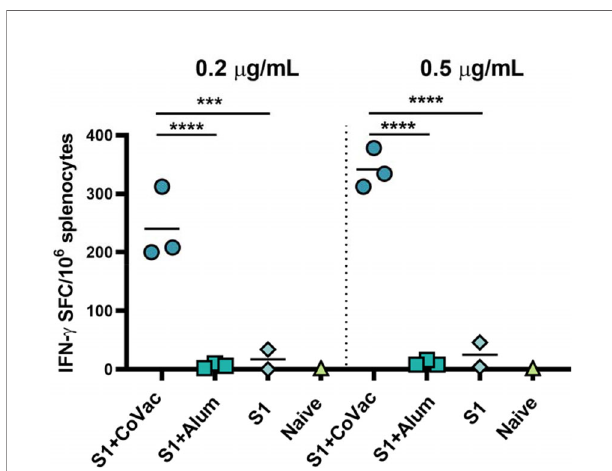
FIGURE 4 | Detection of IFN- g secreting cells from mice immunized with SARS-CoV-2. vaccines. The splenocytes were obtained from mice (2 to 3 per group) immunized with SARS-CoV-2 S1 protein, adjuvanted with CoVaccine HT ™ or Alum, or S1 protein alone on day 28 (one-week after booster immunizations). Pooled splenocytes obtained from two naïve mice were used as controls. The cells were incubated for 40 h with PepTivator ® SARS-CoV-2 Prot_S1 peptide pools at 0.2 m g/ml or 0.5 m g/ml per peptide or medium. IFN- g secreting cells were enumerated by FluoroSpot as detailed in the methods section. The results are expressed as the number of spot forming cells (SFC)/ 10 6 splenocytes after subtraction of the number of spots formed by cells in medium only wells to correct for background activity. Signi fi cance of differences between groups was determined by one-way ANOVA followed by a “ Tukey ’ s multiple comparison ” ***p ≤ 0.001, ****p ≤